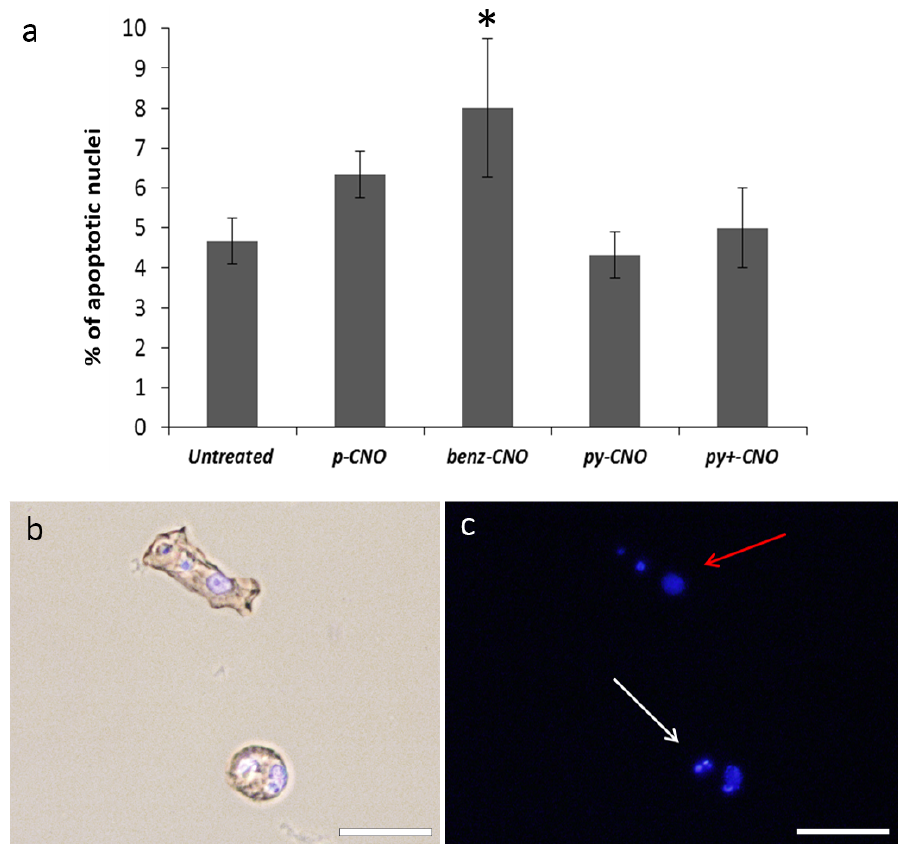
Figure 7. Cellular assessment of apoptosis induction by CNO nanoparticles. Following 24 h incubation in 0.05 mg/mL CNO dispersions, polyps were macerated into single cells and the percentage of apoptotic nuclei was determined by counting the DAPI-stained fragmented nuclei. ( a ) The graph represents the percentage of apoptotic nuclei in normal and treated conditions. Benz-CNO treatment induces a significant increase of apoptotic nuclei (the asterisk denotes statistical significance according to a one-way ANOVA analysis followed by Tukey’s multiple comparison post-test, p < 0.001). ( b ) Fluorescence microscopy imaging of single cells prepared from CNO-treated Hydra . The morphology observed by phase contrast indicates an ectodermal epithelial cell. Scale bar: 20 µm. (c ) Fluorescence imaging following DAPI staining shows a normal nucleus (red arrow) and a typical apoptotic pyknotic nucleus (white arrow). Scale bar: 20